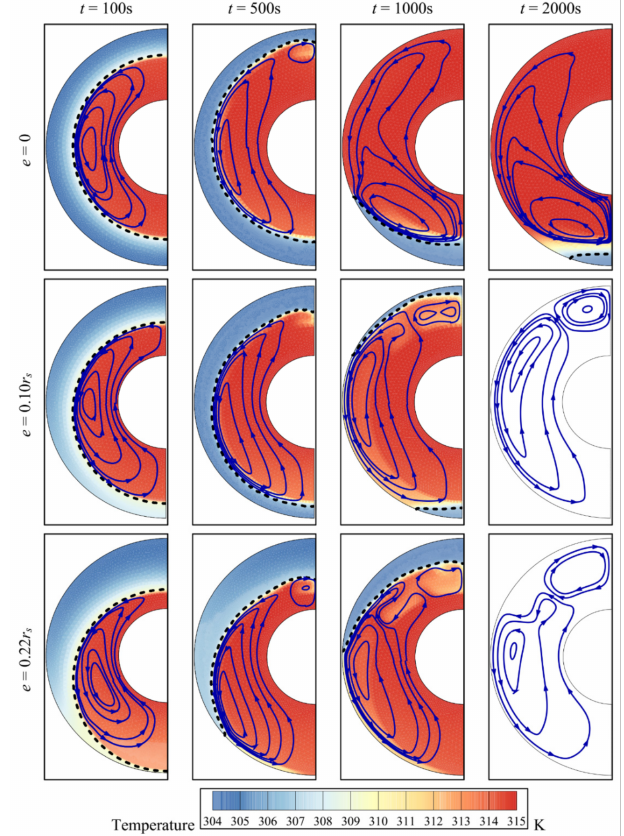
Figure 10. Isotherms, streamline, and interface of melting for different eccentricity values at four charging times for copper nanoparticles as additives with an eccentricity e of 0.12 r s , a foam porosity ε of 0.8, and a nanoparticle volume fraction σ of 0.04.